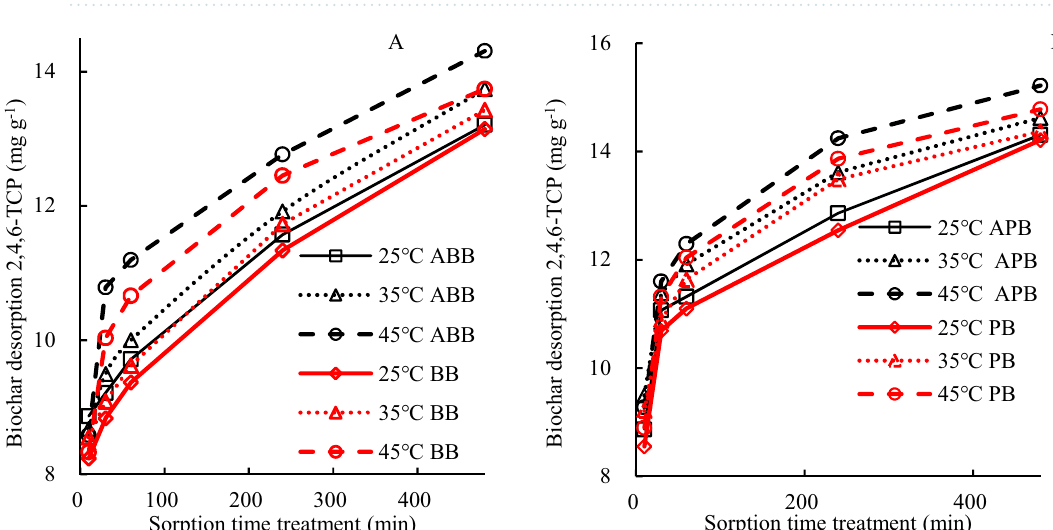
Figure 6. The biochar desorbing 2,4,6-TCP at different time and temperature ( A ) ABB and BB, ( B ) APB and